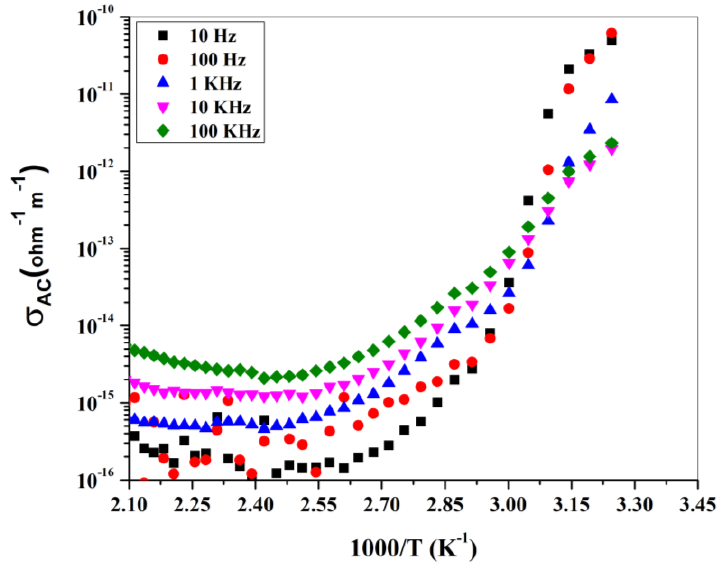
Figure 8. Arrhenius plot (ac conductivity study) of gahnite ferroan composite at different frequen- cies.